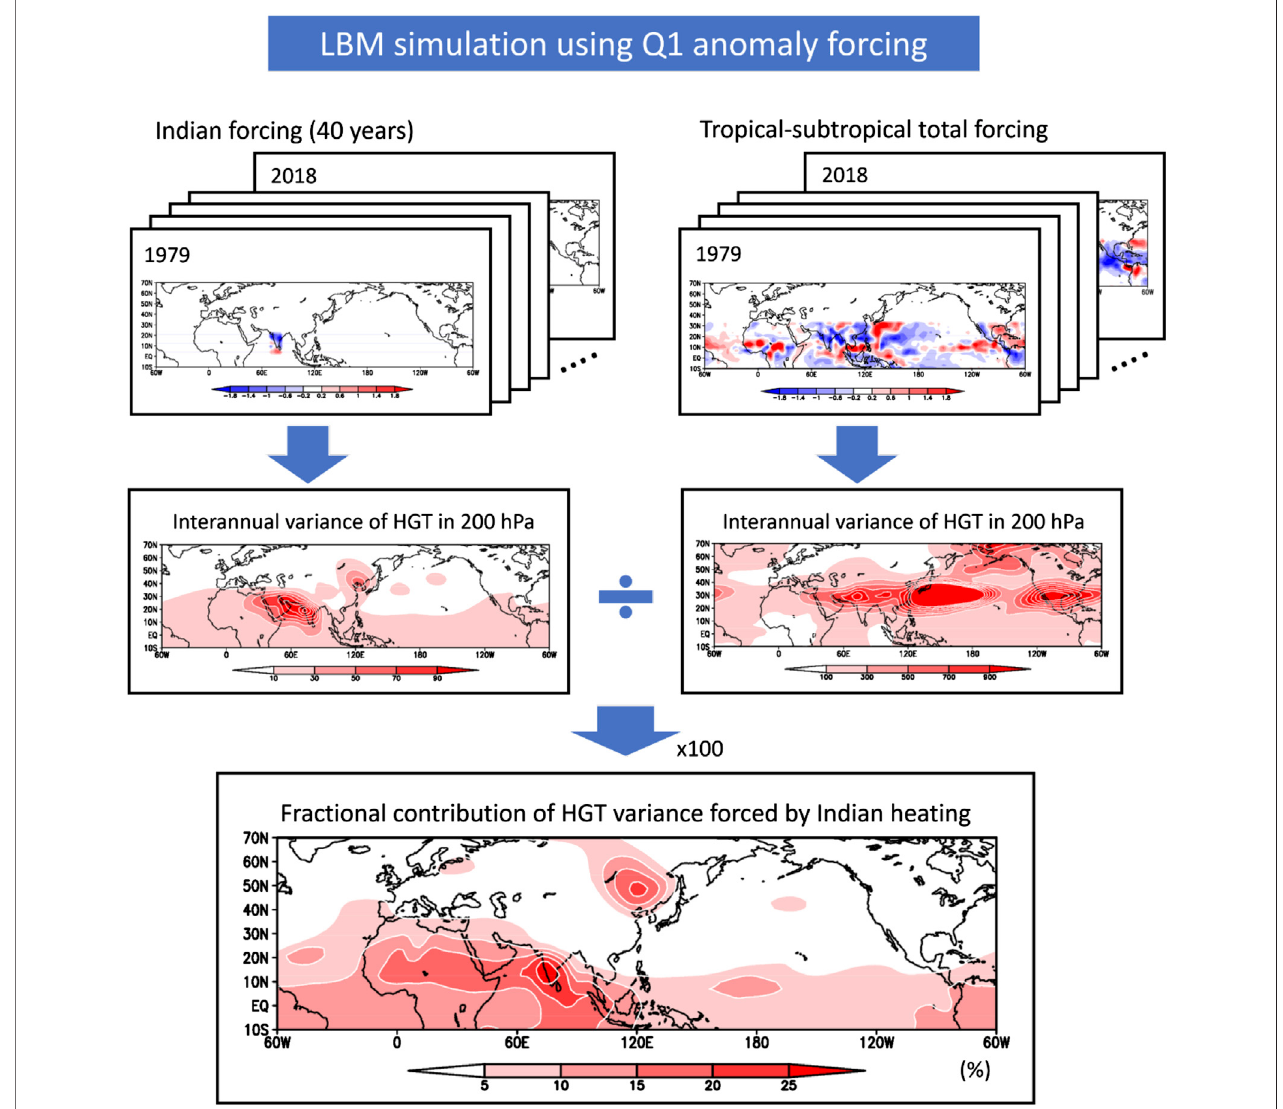
FIGURE 8 | LBM simulations to calculate a percentage contribution (%) of geopotential height in 200 hPa forced by Indian Q1 anomaly.